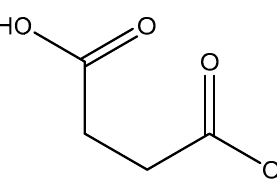
Figure 14. Structural illustration of the magnesium malic acid structure reported by Van Havere [102]. The structure is devoid of interstitial water.